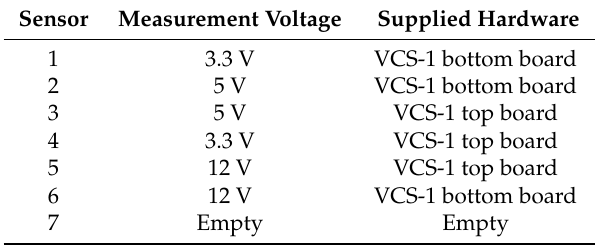
Table 1. Built-in current sensors to monitor power